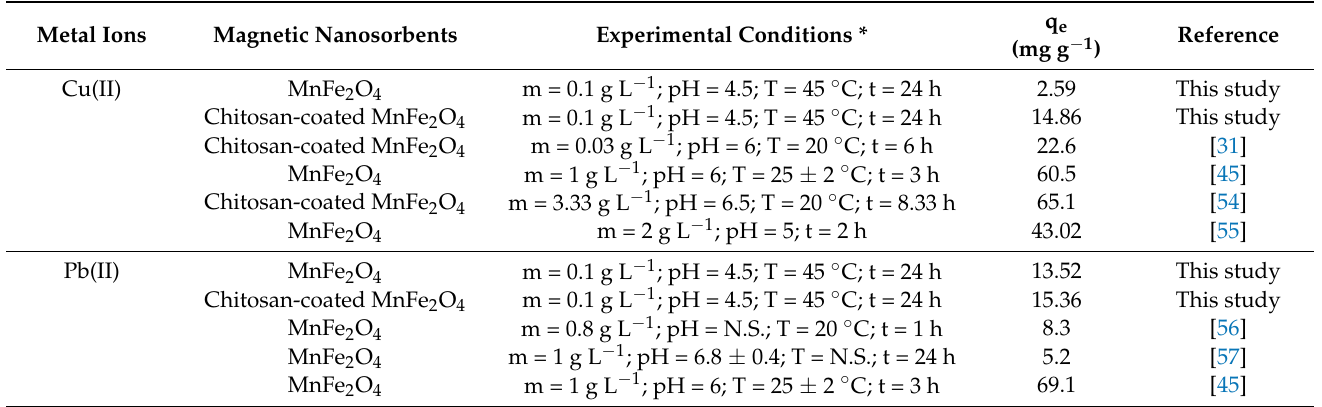
Table 4. Adsorptive performances of various MFO-based nanoadsorbents for Cu(II) and Pb(II). Metal Ions